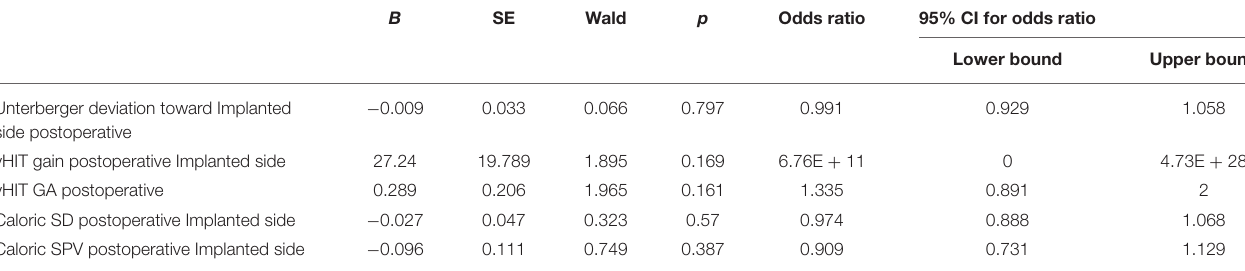
TABLE 4 | Correlation of postoperative test battery scores and development of postoperative vertigo (logistic